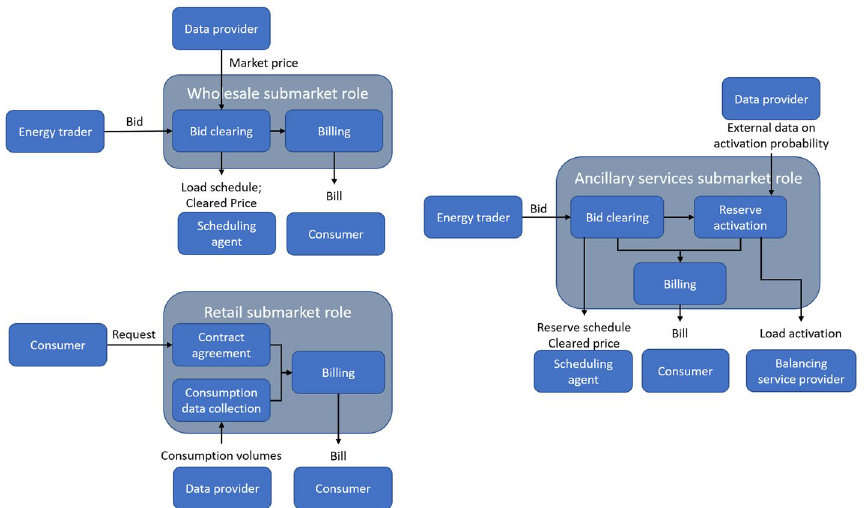
Fig. 3 Roles assigned to different submarket